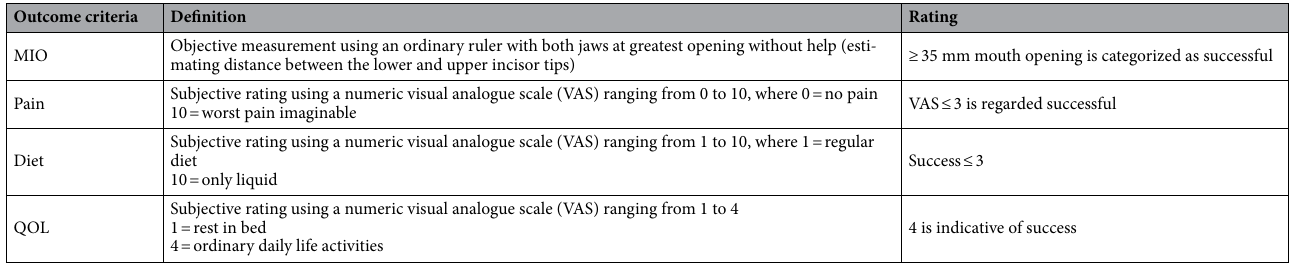
Table 1. Definitions and ratings of different outcome